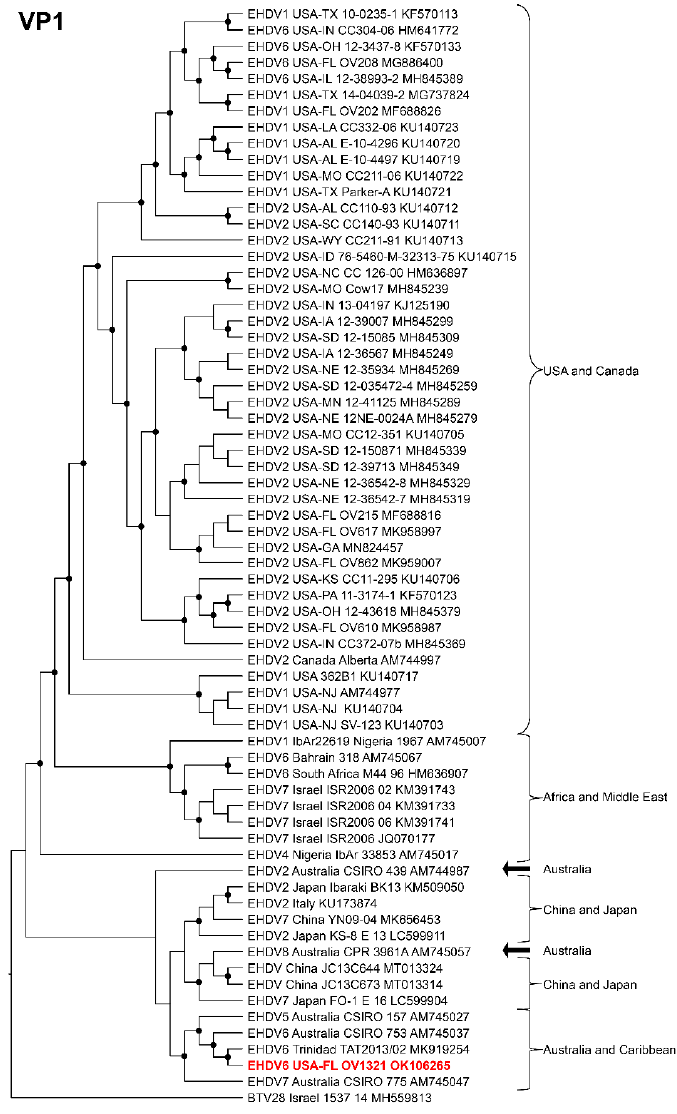
Figure 4. Maximum Likelihood cladogram depicting the relationships of the U.S. novel reassortant EHDV-6 strain isolated from a white-tailed deer (OV1321) to 67 other EHDV strains. The tree was generated from the nucleotide sequence alignment of the VP1 gene. The included EHDV and BTV strains are indicated by serotype, country, state (for U.S. strains), strain or isolate name, and